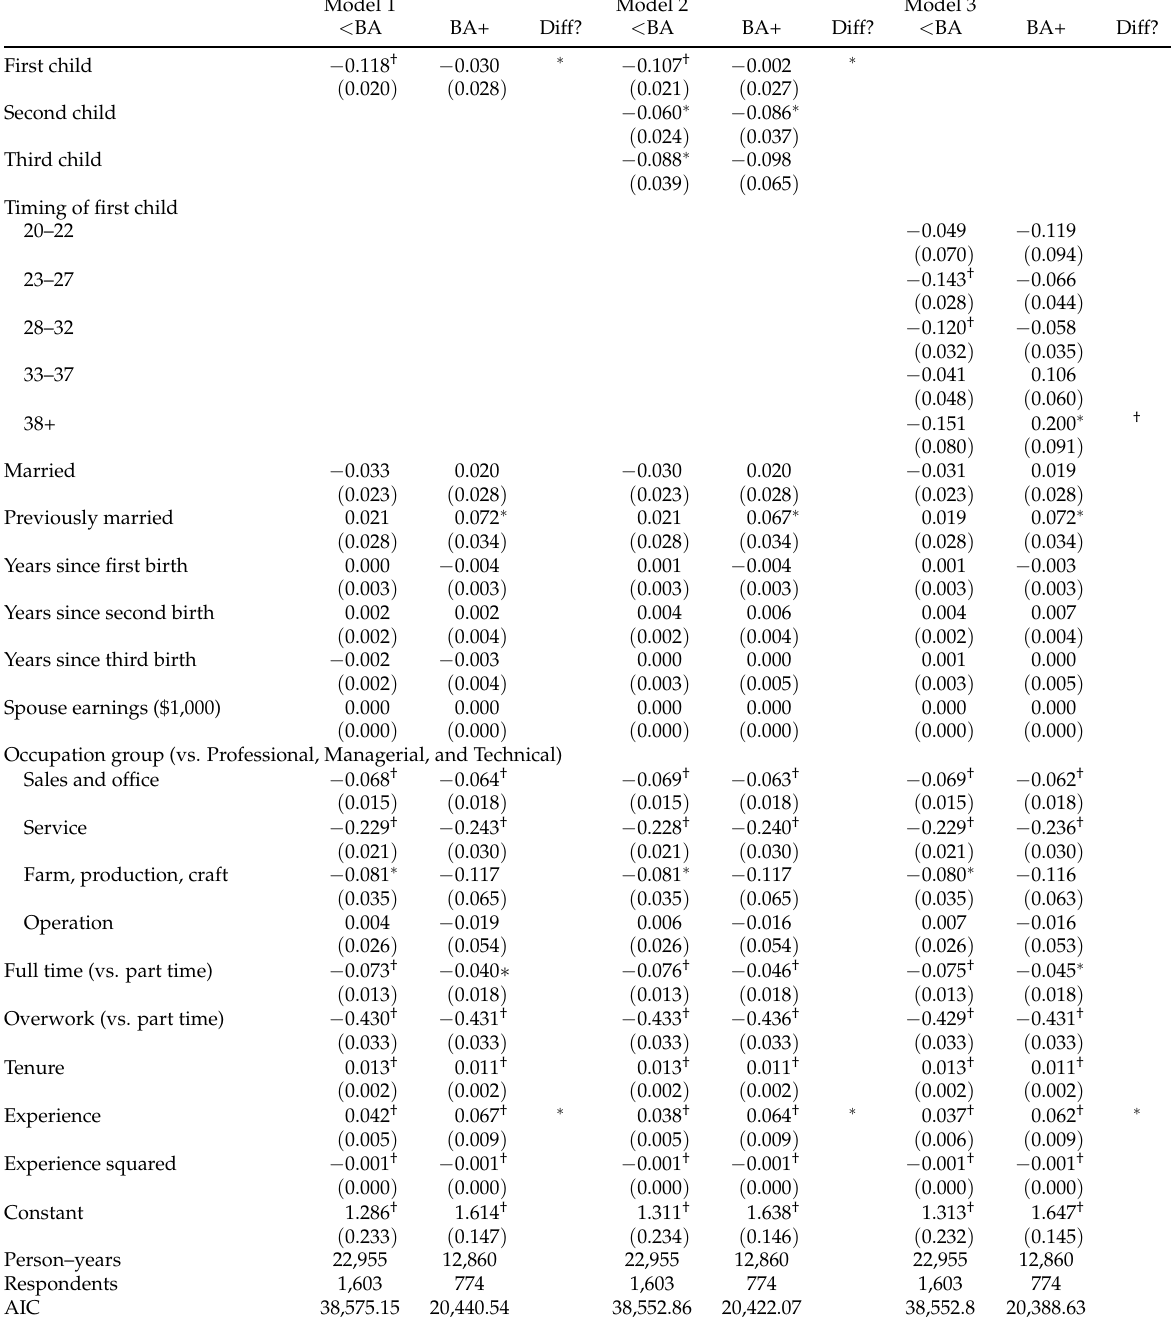
Table 4: Fixed-effects estimates of motherhood, parity, and timing on log wages by education with family